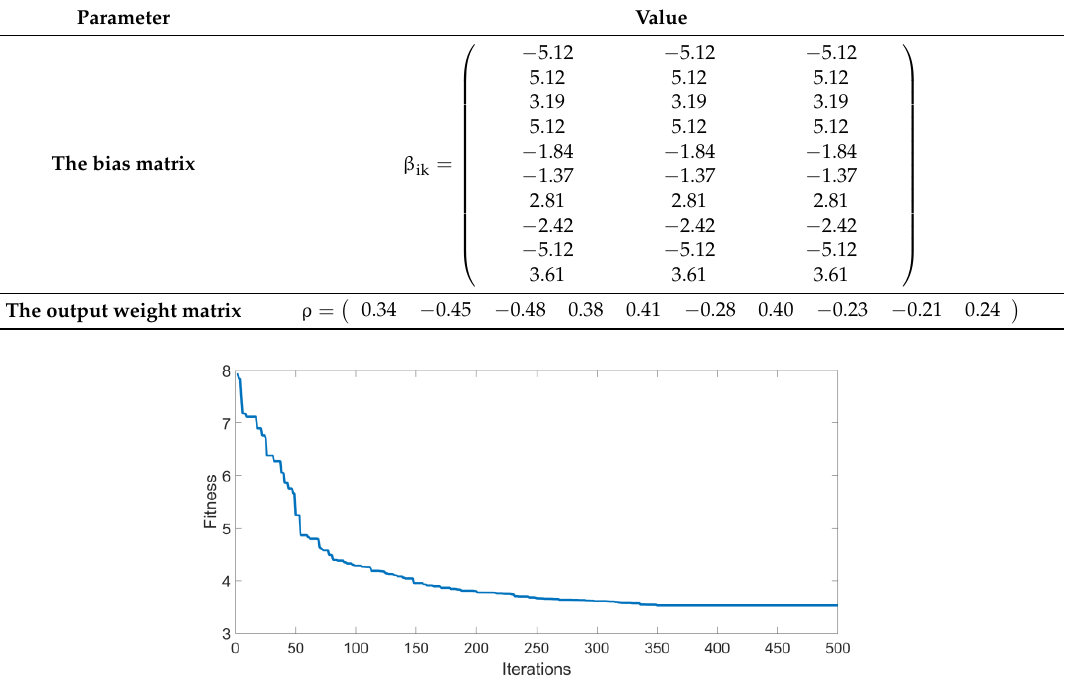
Figure 6. The iterations process of the bat algorithm (BA).